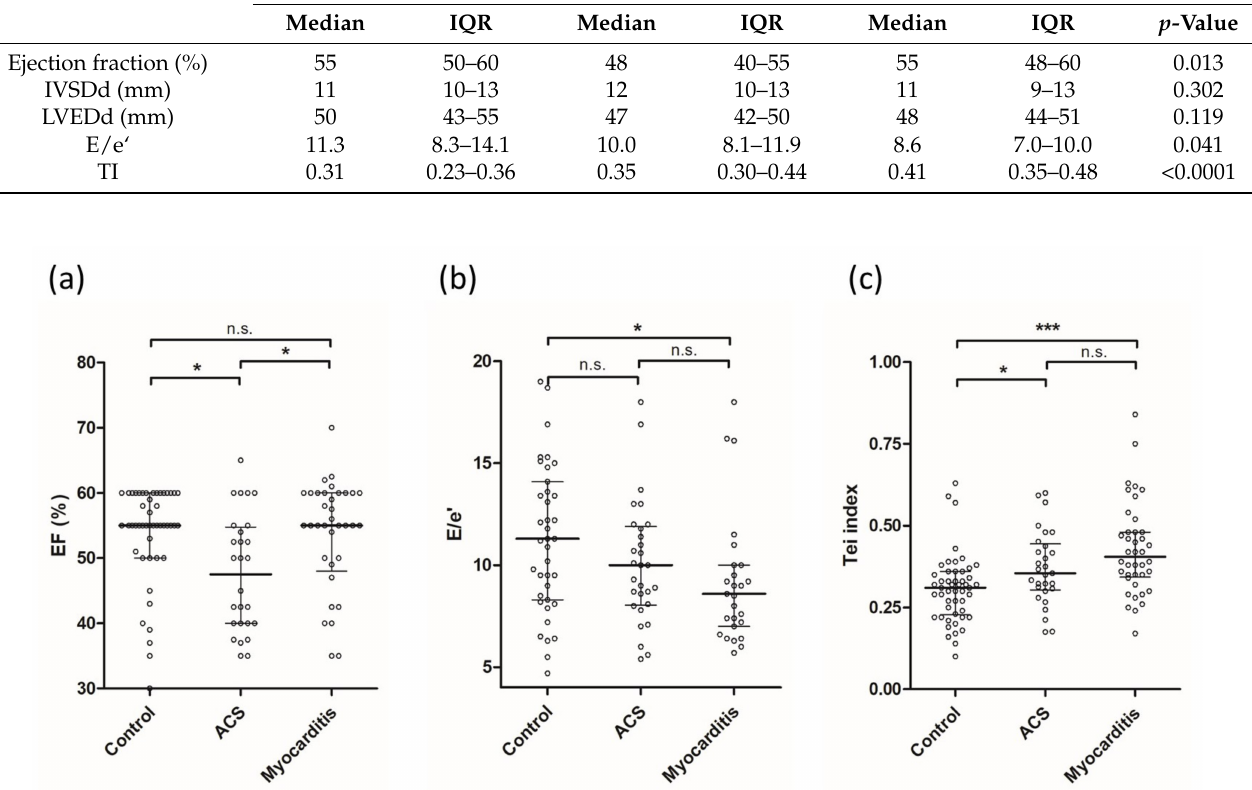
Figure 1. Scatter plots of ( a ) EF, ( b ) E/e‘ and ( c ) TI in patients of both groups. Depicted are median and interquartile range; *** denotes a p -value < 0.0001, * denotes a p- value < 0.05, n.s. = not